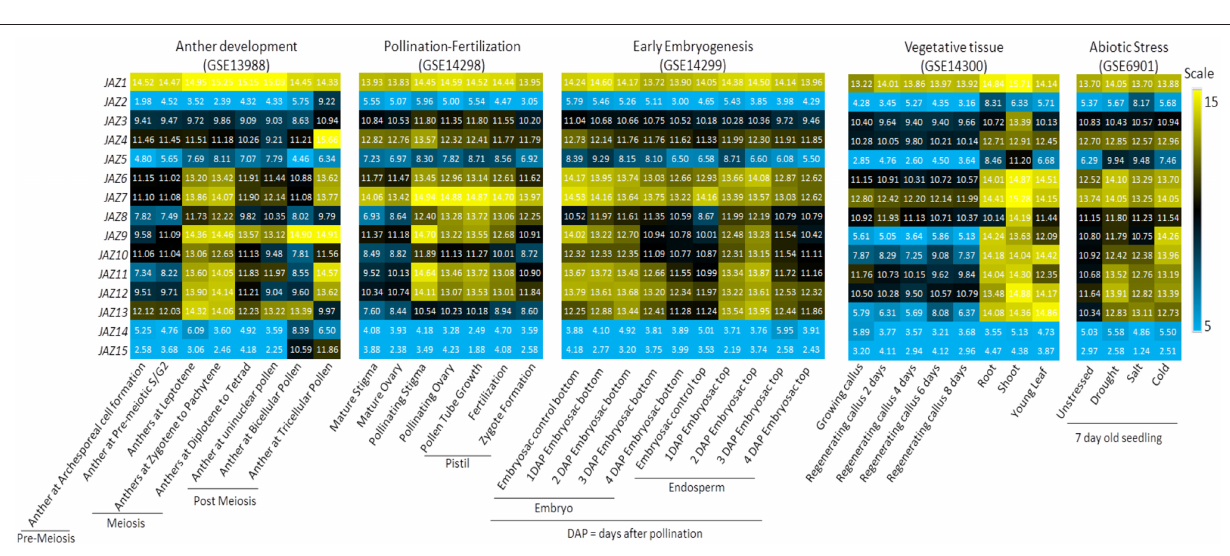
FIGURE 5 | Expression of rice JAZs in various developmental stages and in response to abiotic stress. JAZ expression is examined during reproductive development, vegetative tissues, and under abiotic stress conditions. Reproductive stages are further divided into anther development, pollination to fertilization of pistil and early embryogenesis stages. Heatmaps are made on average log expression values obtained from rice Affymetrix expression data (indicated in white font). Experiment IDs of the microarray-experiments used for analysis are indicated on top of the heatmaps. Gene names for respective expression are shown on the extreme